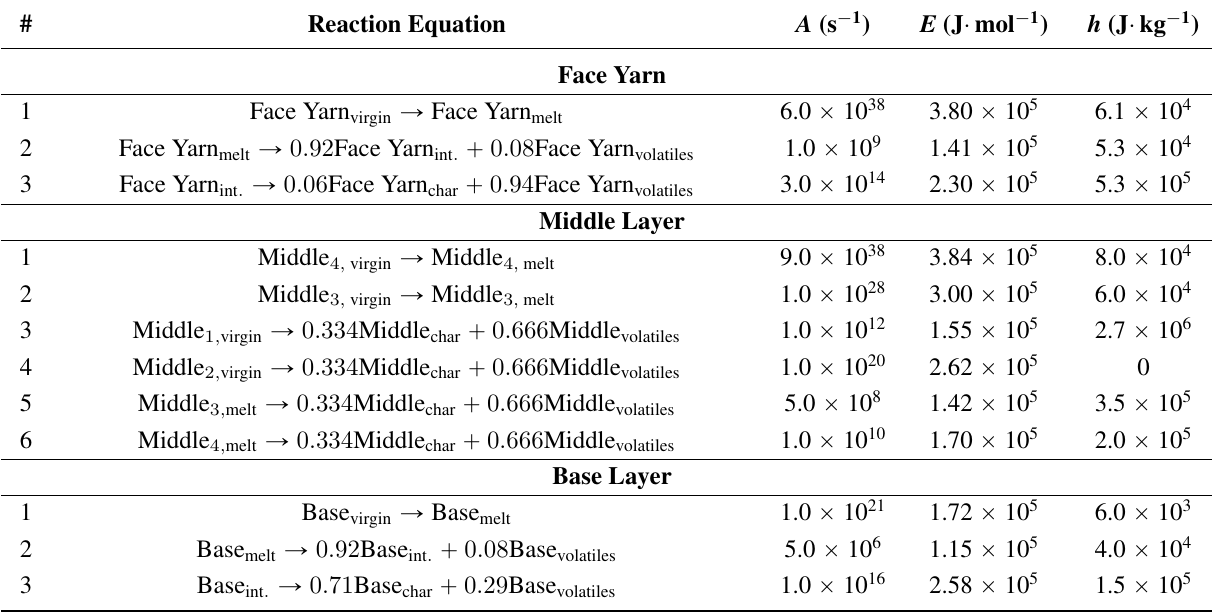
Table 1. Effective reaction mechanisms for each layer of the carpet composite and the heats of reactions. Positive heats represent endothermic